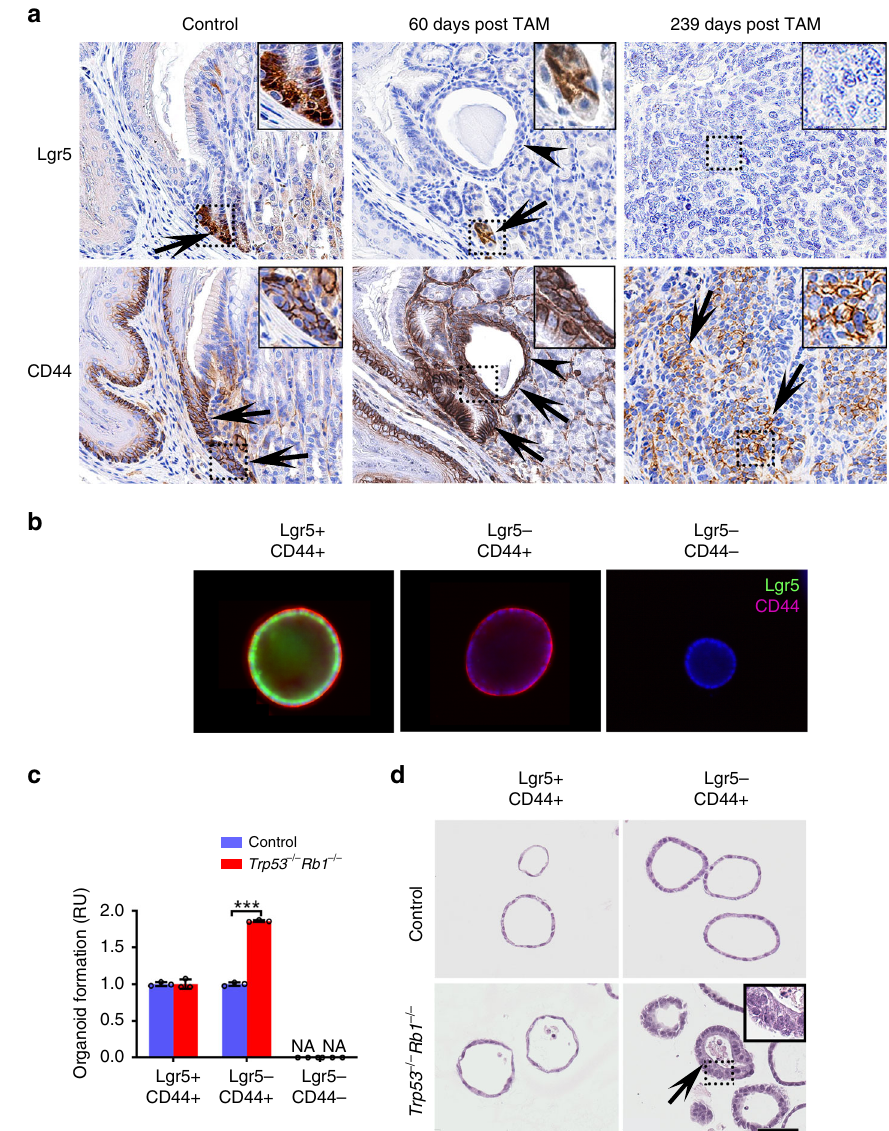
Fig. 3 Lgr5 − CD44 + cells of SCJ show preferential malignant transformation. a Detection of Lgr5-eGFP (arrows in top panels, and CD44 (arrows in bottom panels) in the gastric SCJ before (Control) and after (60 days post TAM and 239 days post TAM) tamoxifen (TAM) administration to Lgr5 eGFP − Ires − CreERT2 Trp53 loxP/loxP Rb1 loxP/loxP Ai9 mice. Early stage dysplastic lesions (arrowheads, TAM + 60 days) and advanced carcinoma (TAM + 239 days) are shown at the SCJ region. Punctate rectangles indicate areas shown in insets. b Gastric SCJ organoids prepared from Lgr5 DTR − eGFP ( Lgr5 -DTR) mice and cultured under conditions promoting presence of Lgr5 + CD44 + cells (CHIR99021 and valproic acid), Lgr5 − CD44 + cells (diphtheria toxin), or mature Lgr5 − CD44 − cells (Wnt3a-, FGF-, noggin-, and gastrin- media with diphtheria toxin). Representative immuno fl uorescence of Lgr5-eGFP (turquoise) and CD44 (magenta) of SCJ organoids. c Frequency of gastric SCJ organoids with preferential presence of Lgr5 + CD44 + , Lgr5 − CD44 + , and Lgr5 − Cd44 − cells before (Control) and after Trp53 and Rb1 inactivation ( n = 3 in each group). NA not available. Normalized to control groups. d Morphology of gastric SCJ organoids formed before (Control) and after CRISPR-mediated Trp53 and Rb1 inactivation. Arrows indicate dysplastic changes in transformed organoids 11 days (passage 2) after inactivation of Trp53 and Rb1 . Rectangle indicates area shown in inset. Elite ABC method, hematoxylin counterstaining ( a ), Immuno fl uorescence, DAPI counterstaining ( b ), and hematoxylin and eosin (H&E) staining ( d ). Scale bar in d represents 60 μ m ( a ), 25 μ m ( a , insets), 85 μ m ( b ), 55 μ m ( d ), and 22 μ m ( d , inset). * P < 0.05, *** P < 0.001, two-tailed unpaired t -tests. All error bars denote s.d. Source data are provided as a Source Data fi